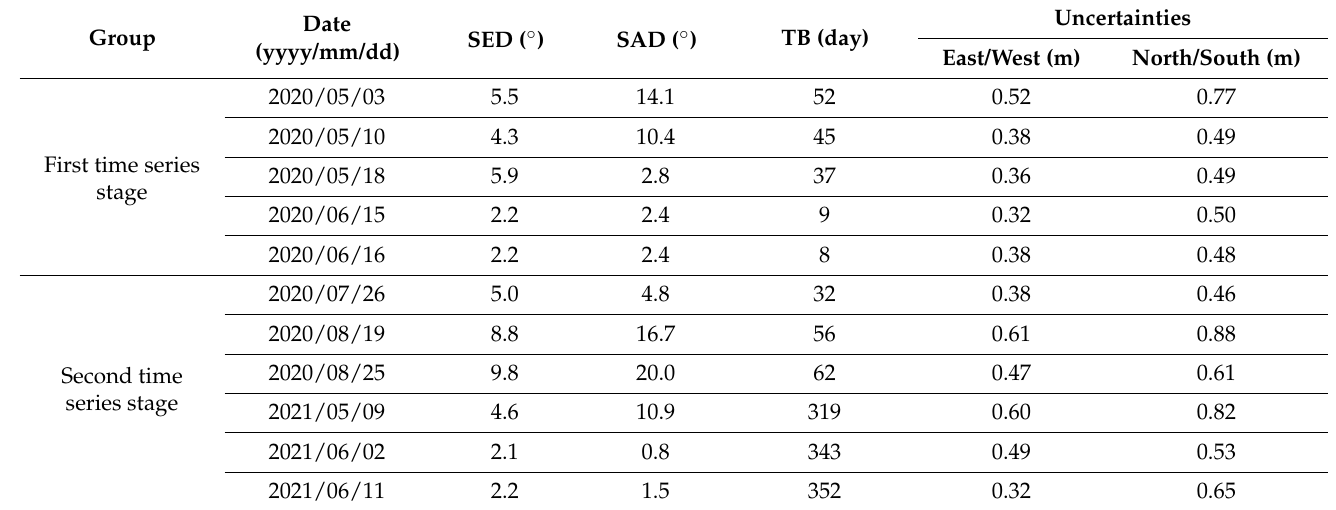
Table 2. Detailed information for the selected first and second time series POT results, including SED, SAD, TB, and uncertainties in the East/West and